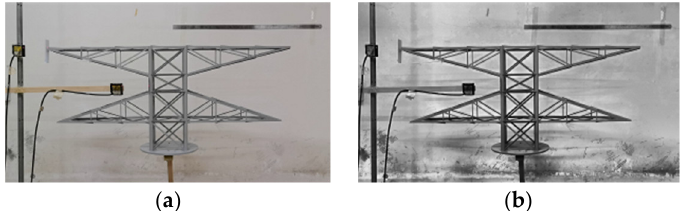
Figure 8. Comparation of grayscale images before and after histogram equalization method. ( a ) Grayscale image before the histogram equalization method. ( b ) Grayscale image after the histogram equalization method.